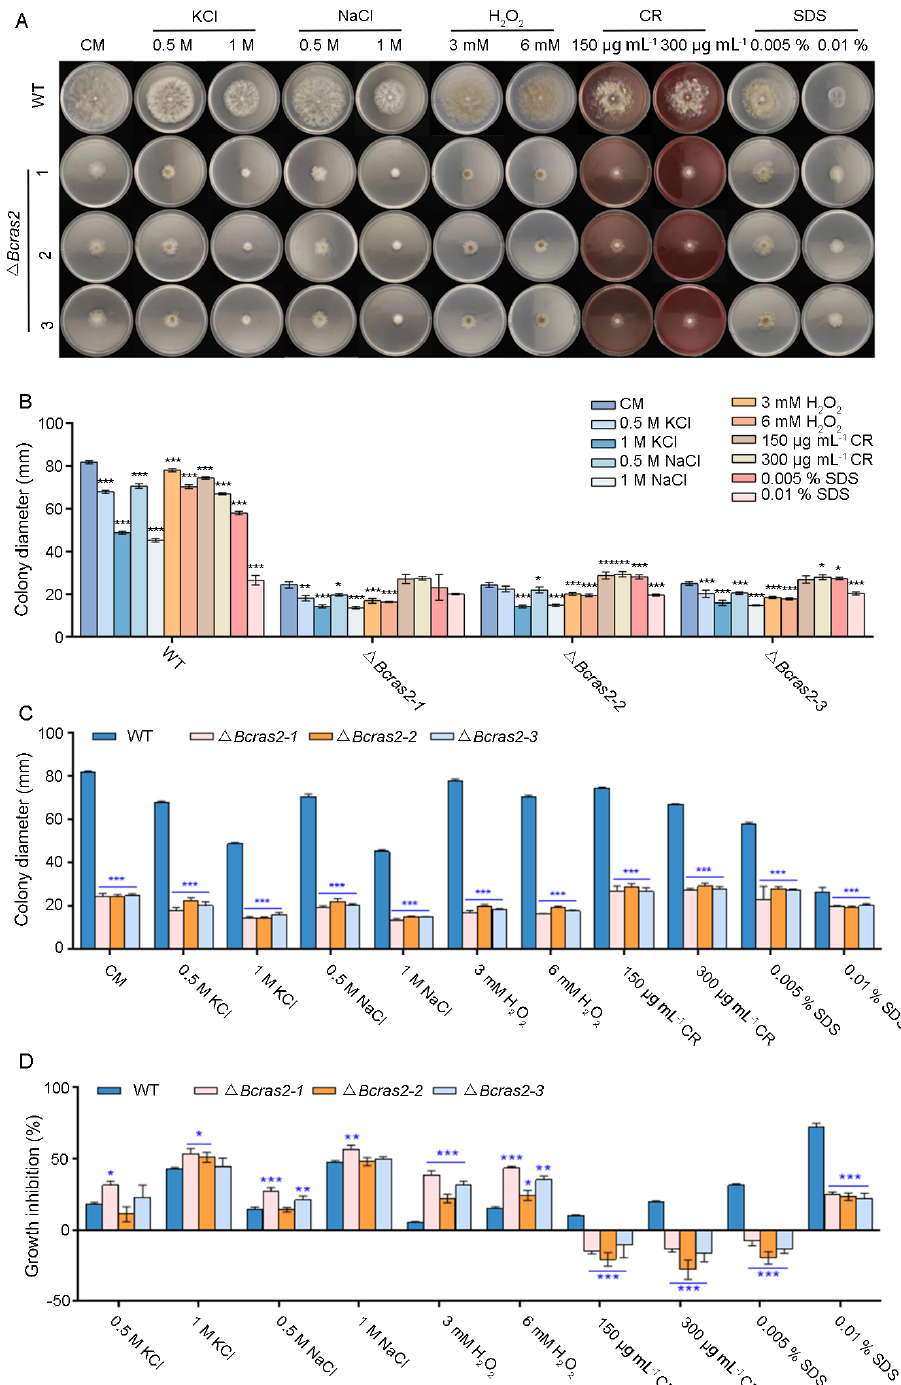
Figure 3. Bcras2 mediates oxidative stress response and cell wall integrity of B. cinerea . ( A ) Conidial suspension (5 × 10 5 conidia mL − 1 ) of ∆ Bcras2 mutants and the wild-type were dropped into CM plates supplemented with the osmotic stress agents KCl (0.5 M, 1 M) and NaCl (0.5 M, 1 M), the oxidative stress agent H 2 O 2 (3 mM, 6 mM), cell wall disturbing agents Congo Red (CR, 150 µ g mL − 1 , 300 µ g mL − 1 ), and sodium dodecyl sulphate (SDS, 0.005%, 0.01%). ( B , C ) Quantification of the relative hyphal growth of different strains on plates with/without stress agents. ( D ) The relative hyphal growth inhibition of the strains on plates supplemented with/without stress agents. Representative photos were taken 3 days post-inoculation. *, **, *** significance at p < 0.05, p < 0.01, and p < 0.001, respectively.